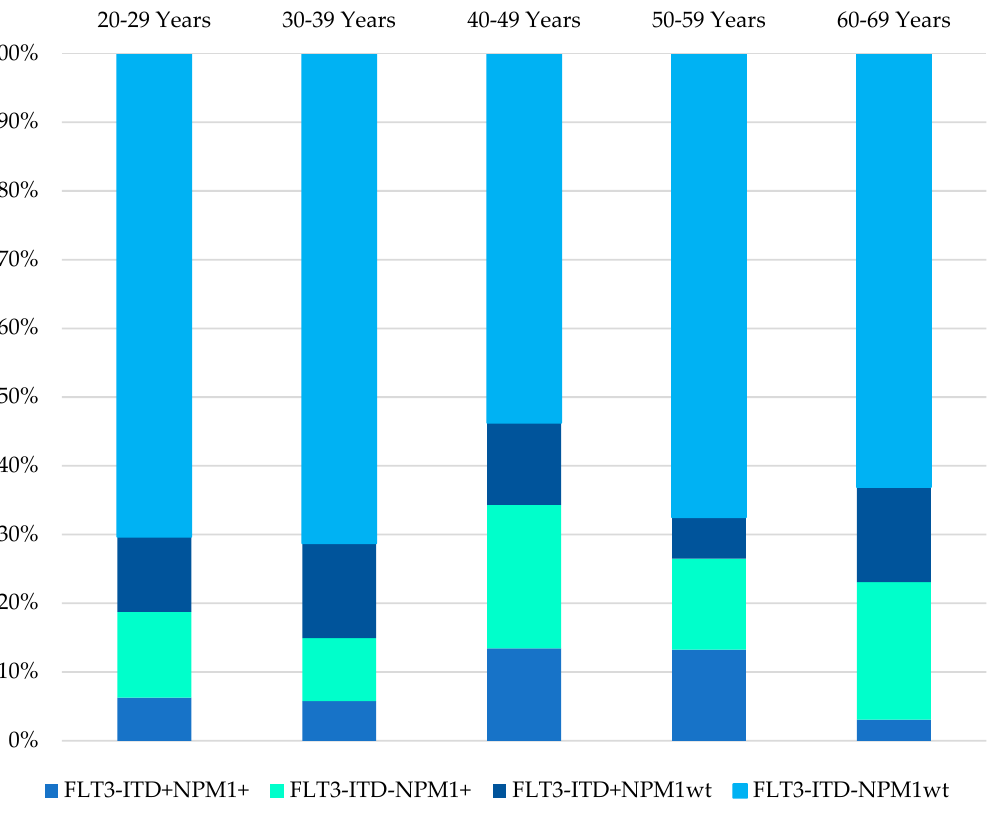
A total of 494 patients were stratified based on 2017 ELN’s recommendation based